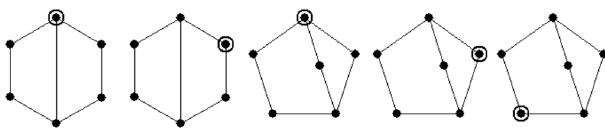
Figure 5. The atlas of 6-link 1-DOF kinematic chain